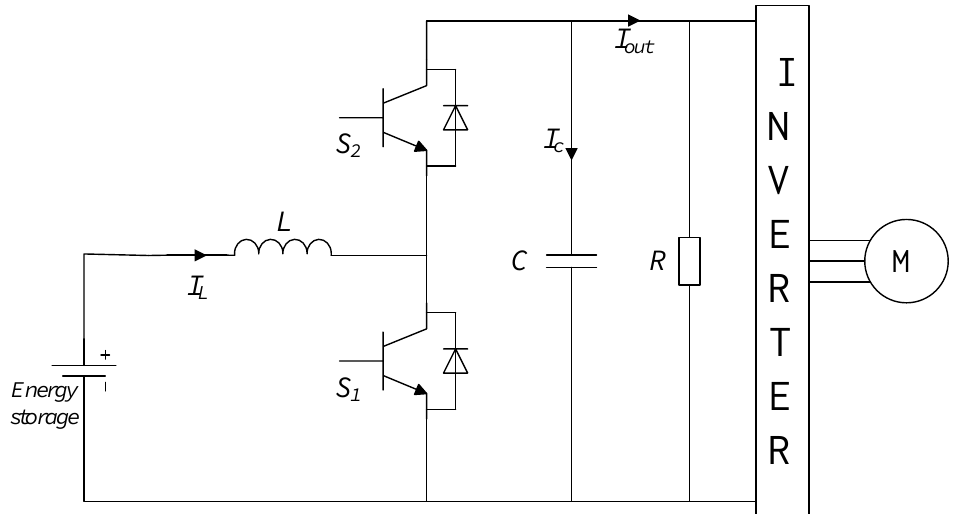
Figure 2. Typical topology of a bidirectional DC-DC converter used in electric vehicles. Electrolytic Capacitor